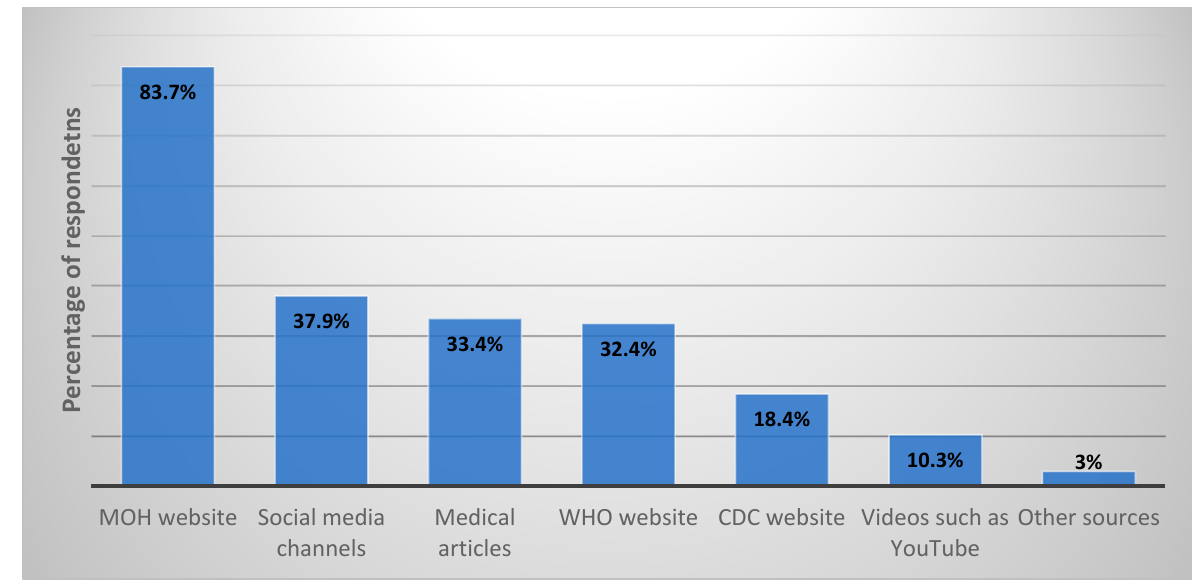
Figure A5. Participant’s sources of information for COVID-19 & vaccines. The majority of participants reported that their main source of information was the Saudi Ministry of Health website (MOH) (83.7%), followed by social media channels and medical articles (37.9%), the World Health Organization (WHO) website and the CDC website (32.4%, 33.4%, respectively), as well as other sources.